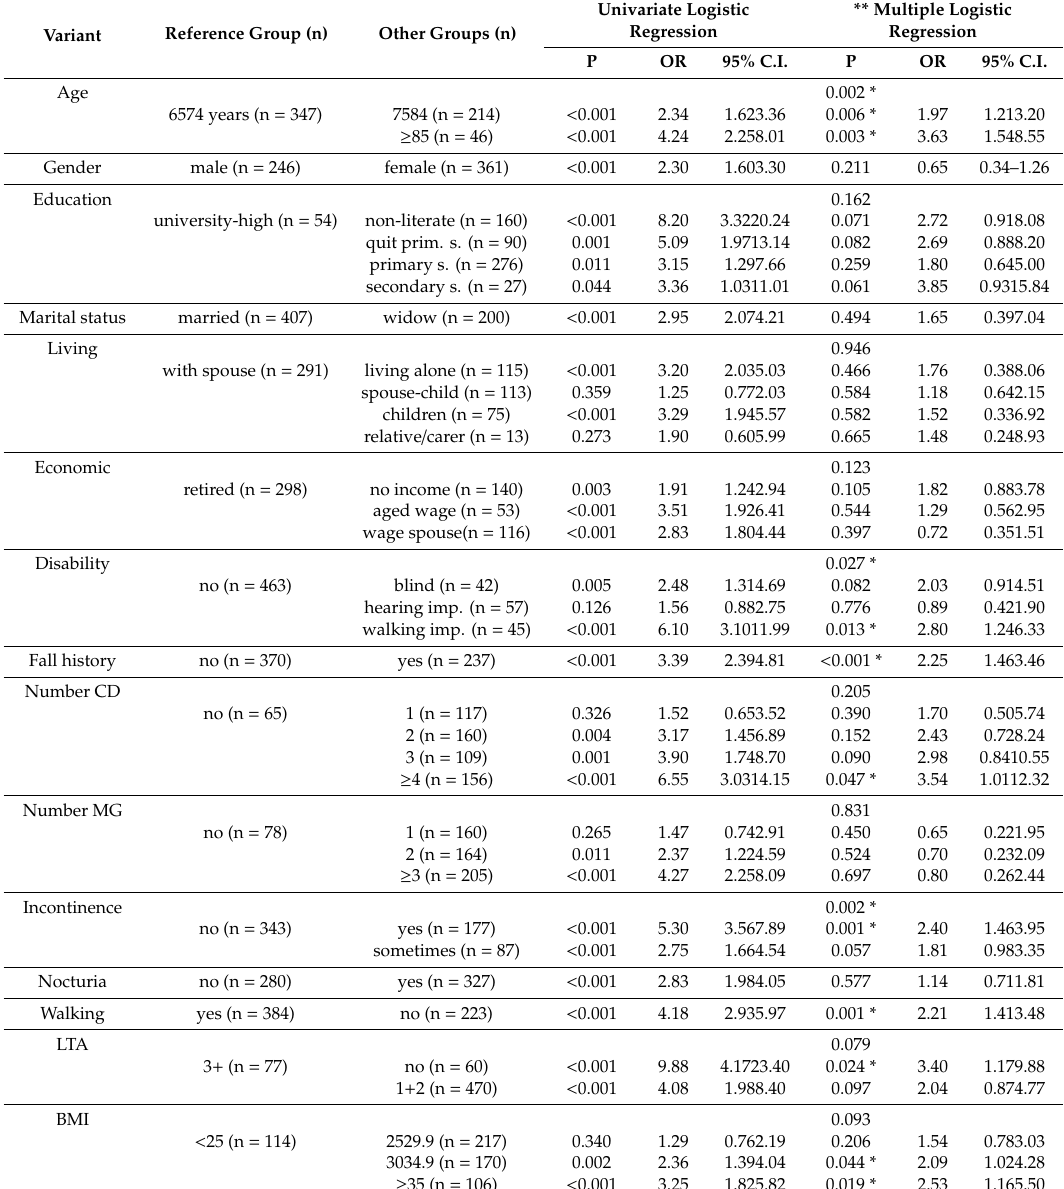
Table 2. Univariate logistic regression analysis and multiple logistic regression